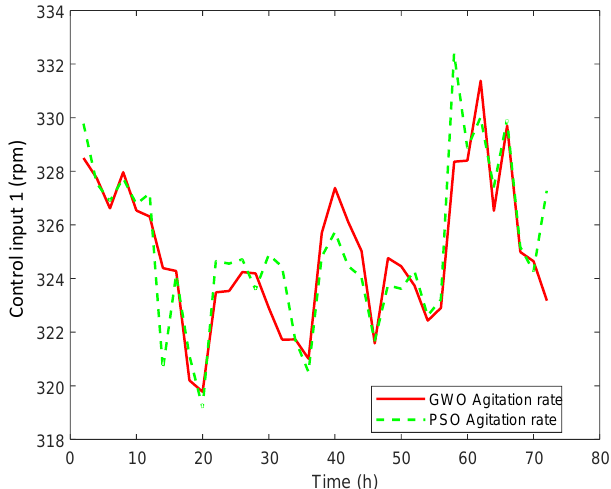
Figure 8. GWO-NMPC controlled agitation rate u 1 with optimal